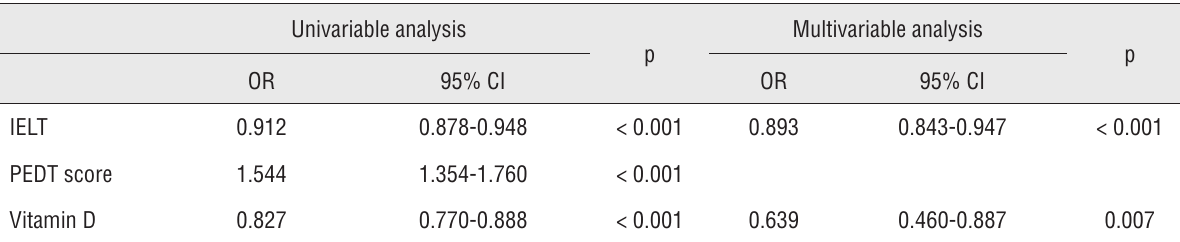
Table 2 - Logistic regression analysis for premature